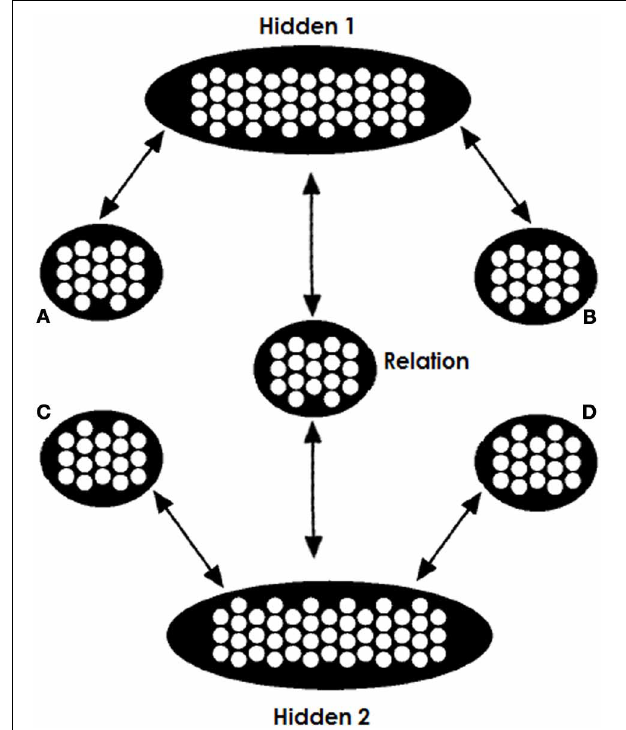
FIGURE 2 | Model’s testing architecture. Two copies of the trained network share a common relation pool, so that both the A and B terms and the C and one candidate D term jointly constrain the search for a relation. While the A, B, and C items are clamped for the entire testing process the D items are clamped only at the beginning. We run two tests, one for each candidate D item; the D alternative with the strongest “echo” of activation at the end of testing is